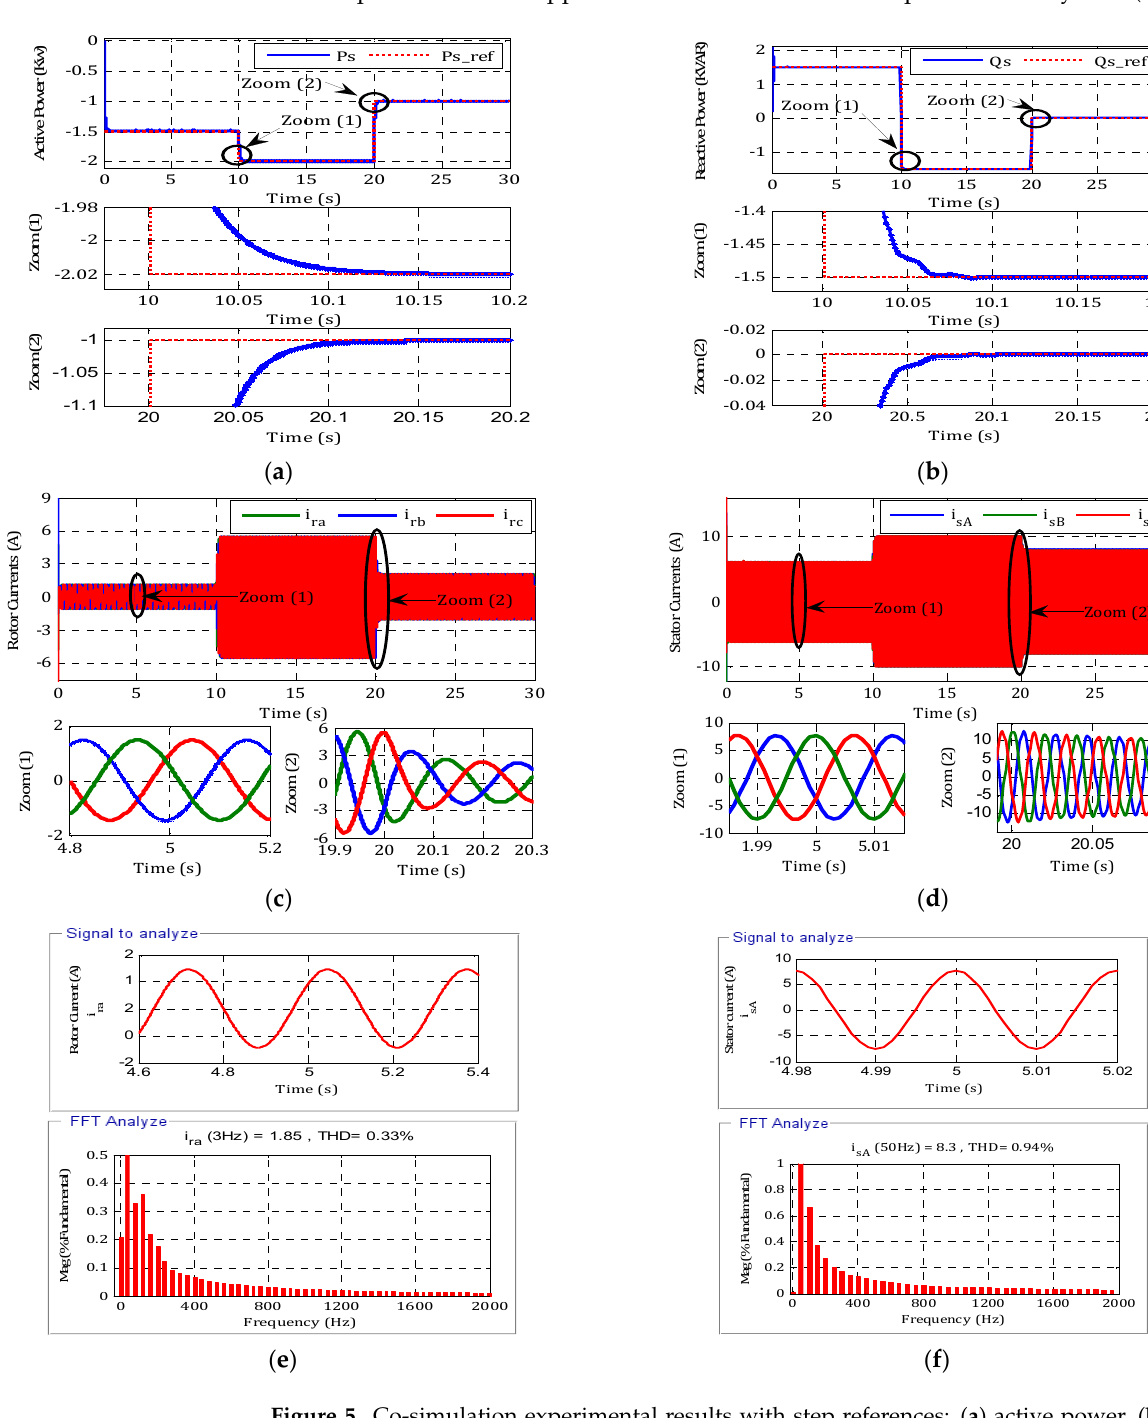
Figure 5. Co-simulation experimental results with step references: ( a ) active power, ( b ) reactive power, ( c ) rotor current, ( d ) stator current, ( e ) THD rotor current, and ( f ) THD stator current.